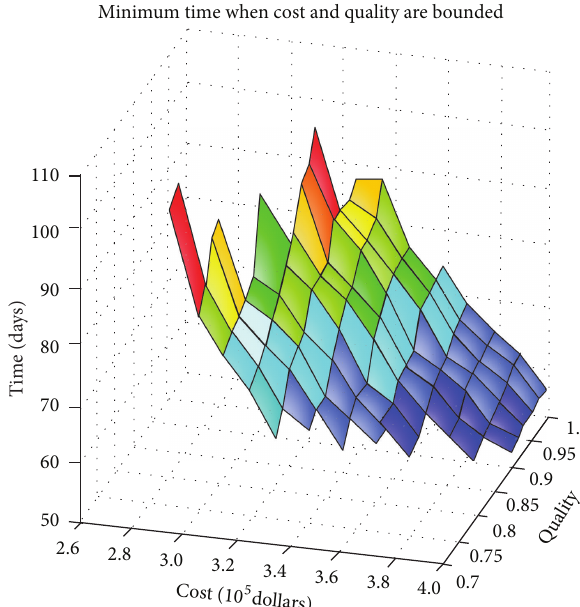
Figure 6: A visual three-dimensional tradeoff pattern among project time, cost, and quality.